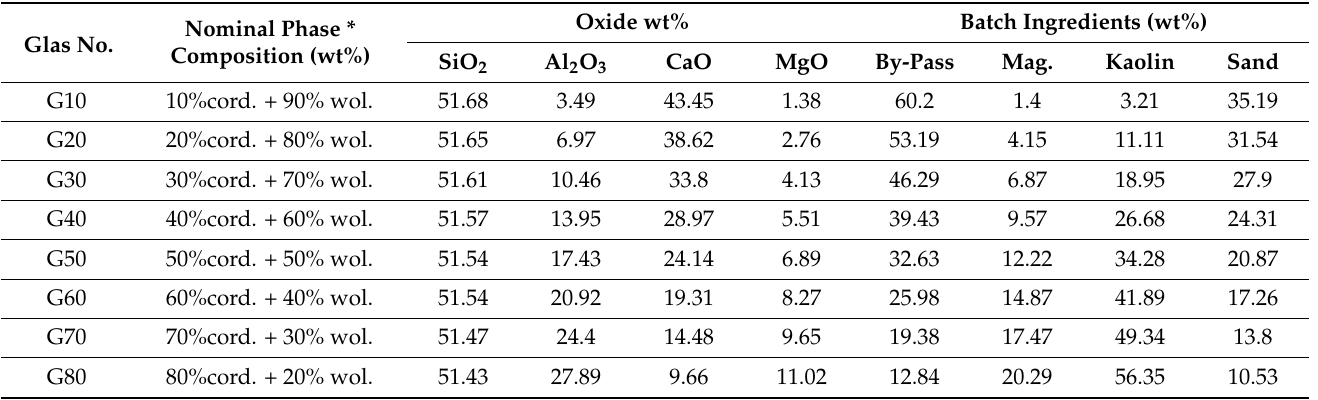
Table 2. Chemical compositions and the corresponding batches (wt%) of the investigated